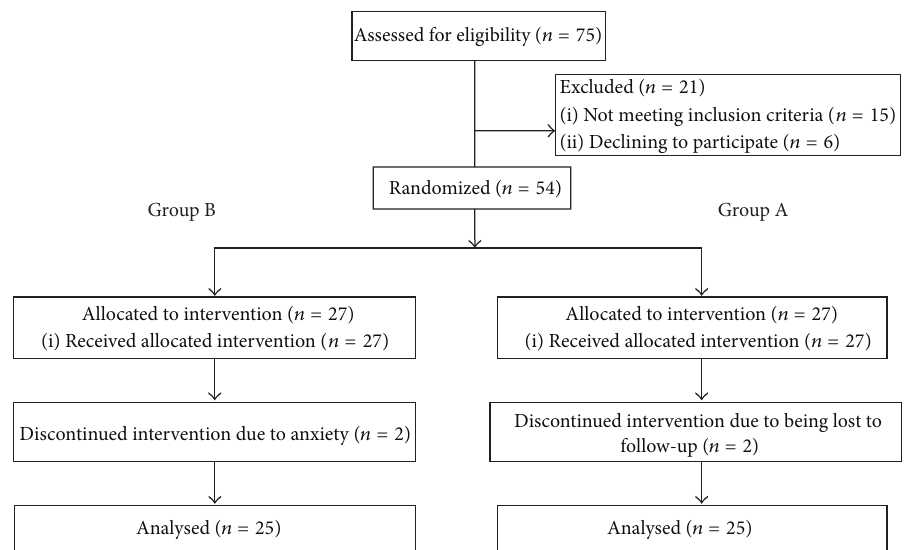
Figure 1: Participant flow diagram (according to guidelines of CONSORT 2010).